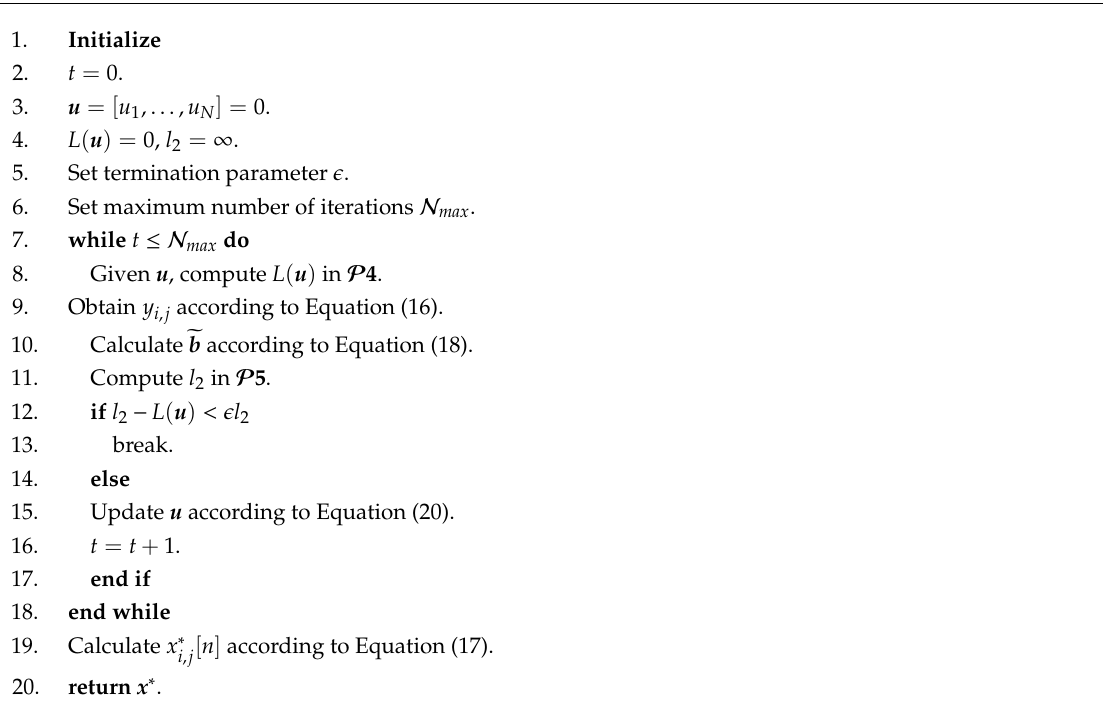
Algorithm 1. Proposed channel assignment.